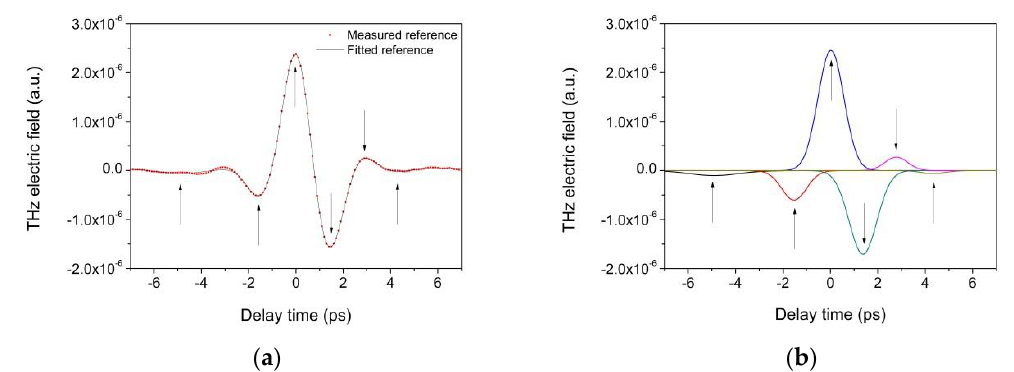
Figure 5. ( a ) Measured (scatter plot) and fitted (line plot) reference pulse; ( b ) Six Gaussians used in the fitting procedure.